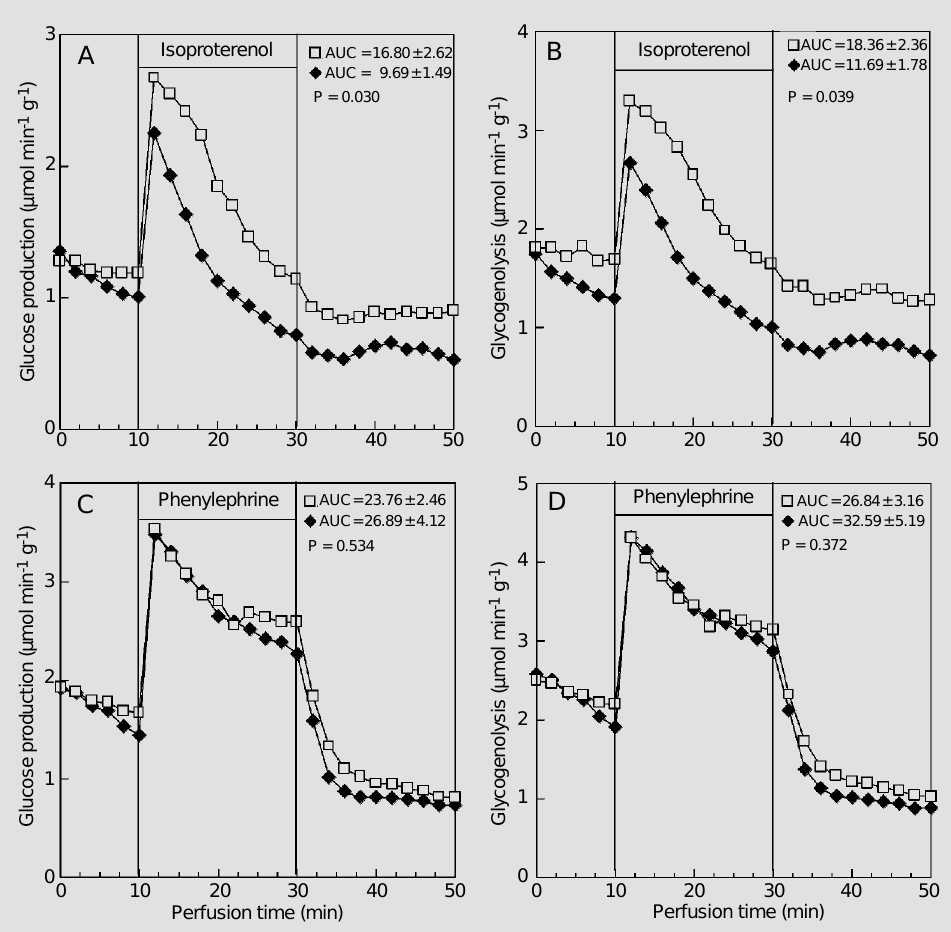
Figure 1 - Effect of isoproterenol (20 µM; panels A and B) and phenylephrine (2 µM; panels C and D) on glucose production and glycogenolysis. The data re- ported are the mean of 5-8 indi- vidual liver perfusion experi- ments performed 30 min after injection of saline (CN group, squares) or insulin (IN group, dia- monds). The livers were per- fused as described in Material and Methods. AUC = Area un- der the curve. The statistical test used was the unpaired Student t